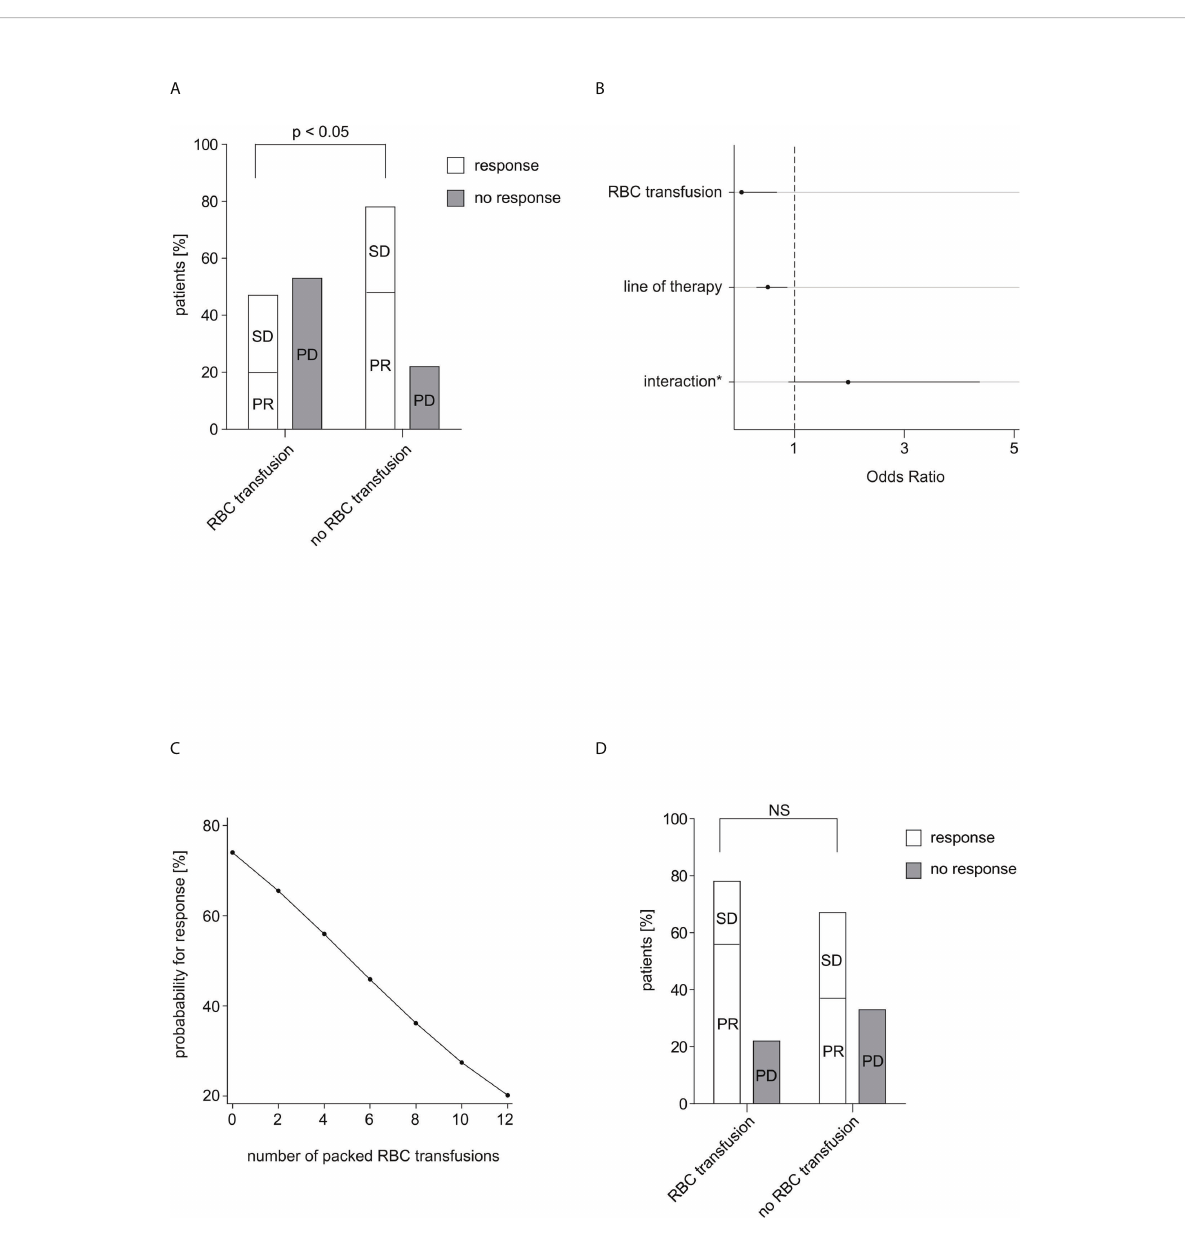
FIGURE 1 Response rate in relation to RBC transfusions. (A) The response rate depending on received RBC transfusions within 60 days after start of IT is shown. Complete response, partial response and stable disease were considered as response. Of 40 patients in the non-transfused group 31 patients (77.5%) responded to IT, while of 15 patients in the transfused group only 7 patients (46.7%) responded to IT. The difference was calculated using Fisher ’ s exact test (p=0.047). (B) Multiple logistic regression analysis of therapy response to IT. (*) between RBC transfusion and line of therapy. After adjustment for the effect of the confounding factor “ line of therapy ” the correlation between therapy response and transfusion was statistically signi fi cant (p=0.026). No other confounding factors could be identi fi ed. (C) The probability for response in dependence on the number of transfused packed RBC units within 60 days after start of IT is depicted. (D) The response rate depending on received RBC transfusions within 30 days before start of IT is shown. Of 46 patients in the non-transfused group 31 patients (67.4%) responded to IT, while of 9 patients in the transfused group 7 patients (77.8%) responded to IT. The difference was calculated using Fisher ’ s exact test (p=0.705). RBC, red blood cell; IT, immunotherapy; PR, partial response; SD, stable disease; PD, progressive disease; NS, not signi fi